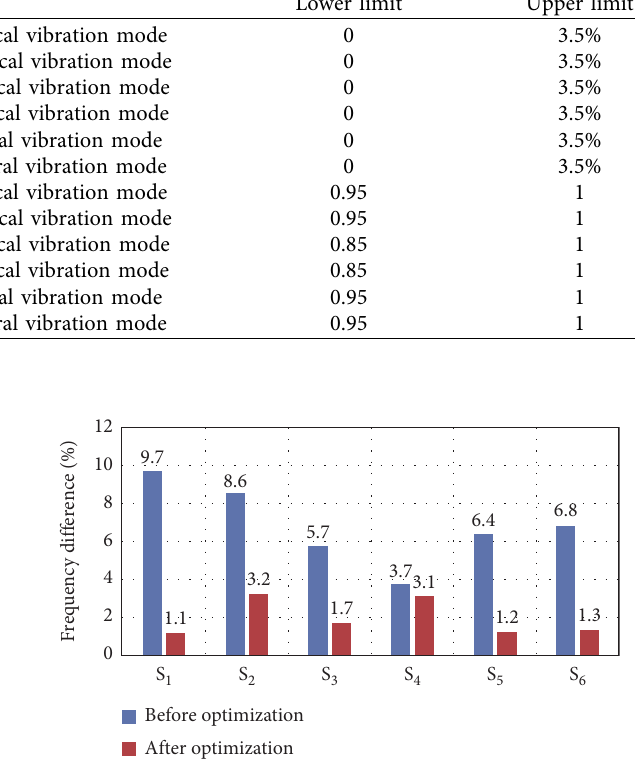
Figure 7: Variation of frequency difference before and after